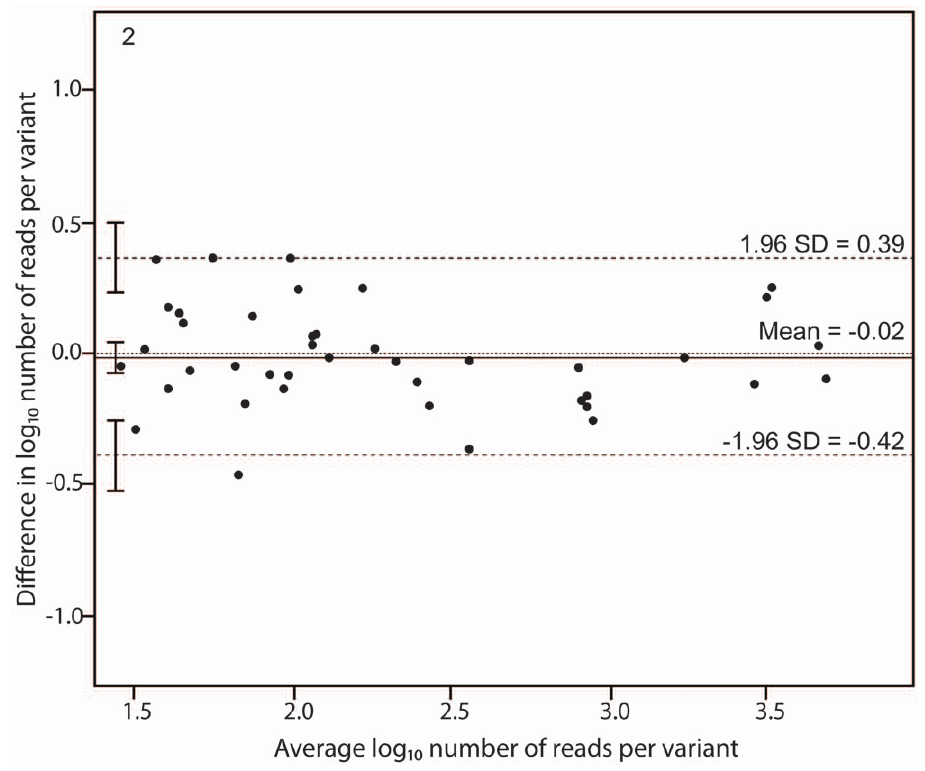
Figure 2. Bland-Altman plot showing the repeatability of variant quantification using UDPS. UDPS was performed twice for sample A and sample B. These paired measurements were combined and the number of reads in the second (repeat) measurement was weighted by the number of reads in the first measurement. The number of reads per variant was log transformed. The differences in number of reads per variant in the repeat analyses are plotted against the average number of reads per variant. Horizontal lines are drawn at the mean difference between the two measurements and at the upper and lower limits of agreement. The 95% confidence intervals are also shown for the mean and the upper and lower limits of agreement.